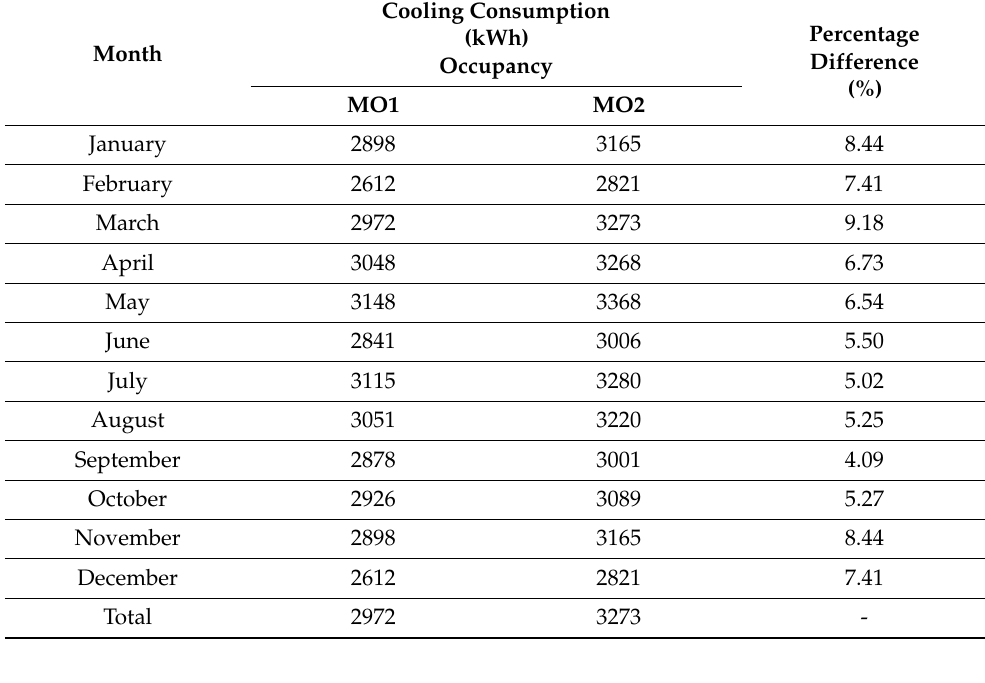
Table 11. Comparison of current consumption due to air conditioning for the previous study (MO1) and the current one (MO2) and their difference percentage.